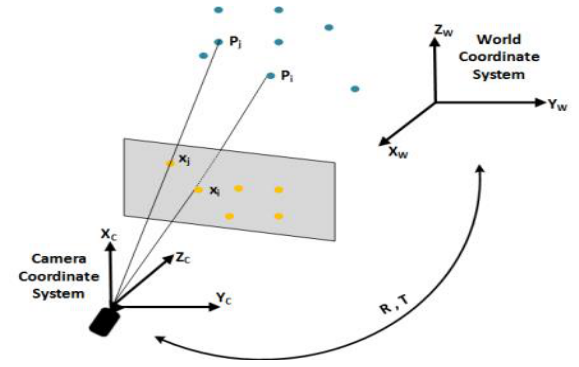
Figure 7. Camera pose estimation using 3D-2D feature points